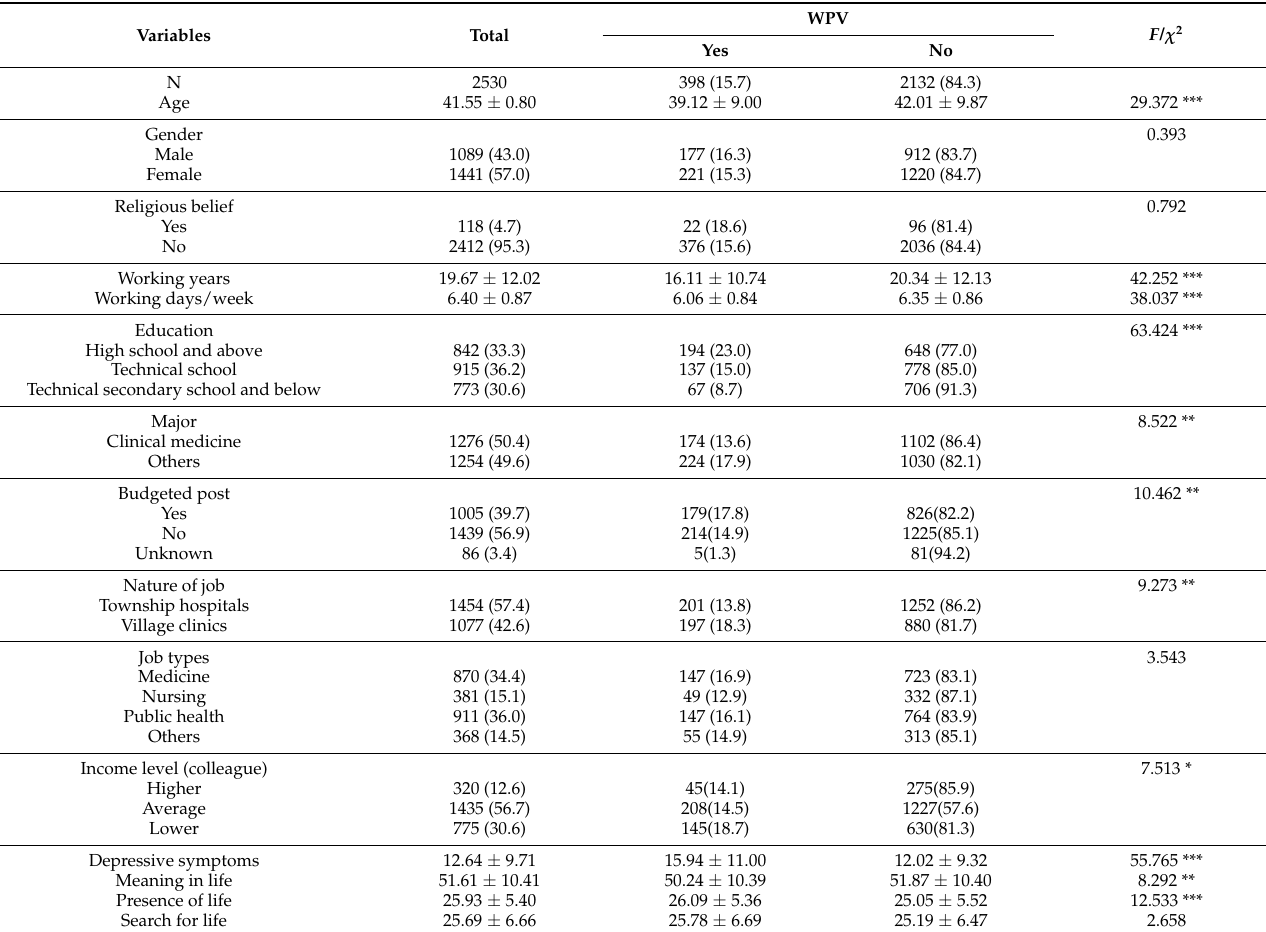
Table 1. Descriptive analysis and differences between primary healthcare professionals experienced workplace violence or not. [M ± SD/N